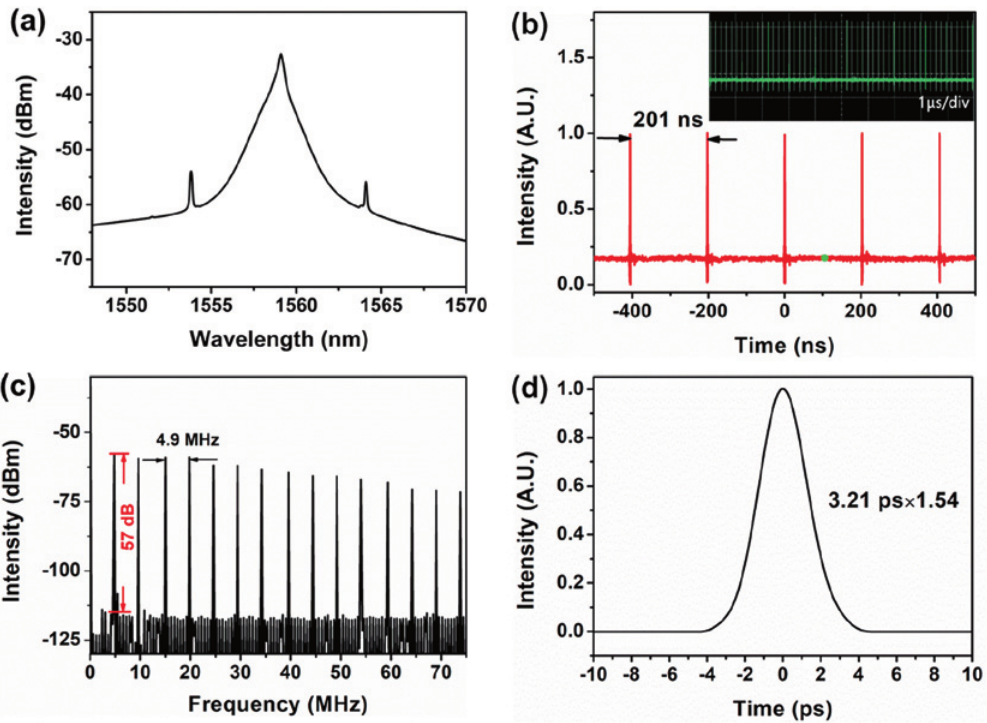
Figure 4: Fundamental mode-locked operation. (a) Optical spectrum. (b) Corresponding pulse train. (c) RF spectrum. (d)